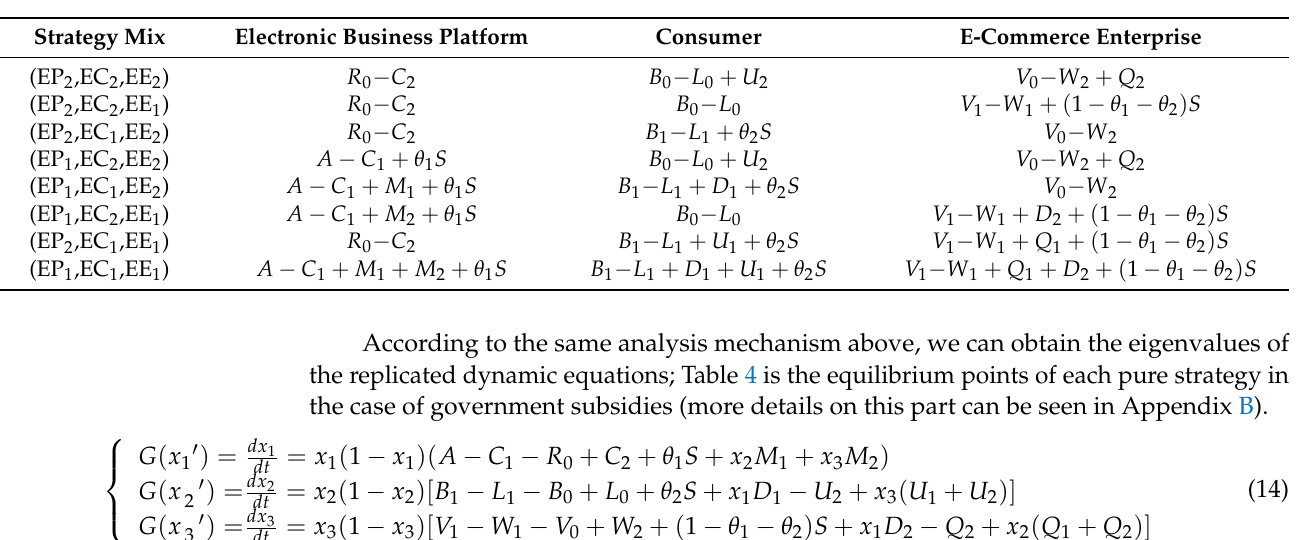
Table 3. Game revenue matrix with government participation.